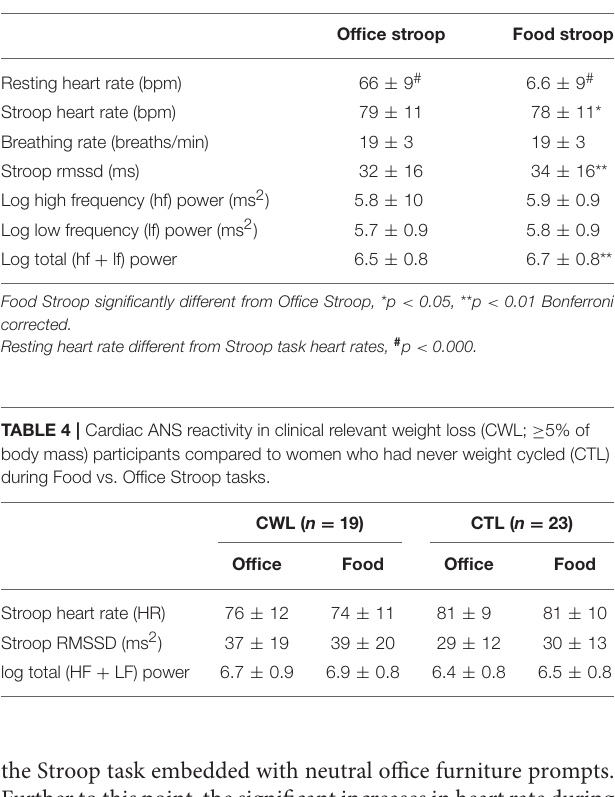
TABLE 3 | Cardiac ANS reactivity: Food vs. Office Stroop tasks when groups were combined.